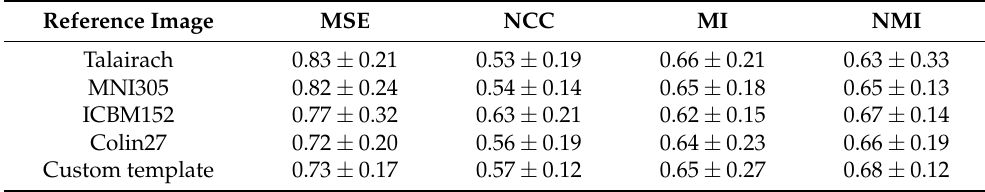
Table 6. The comparison of registration results of standard human brain